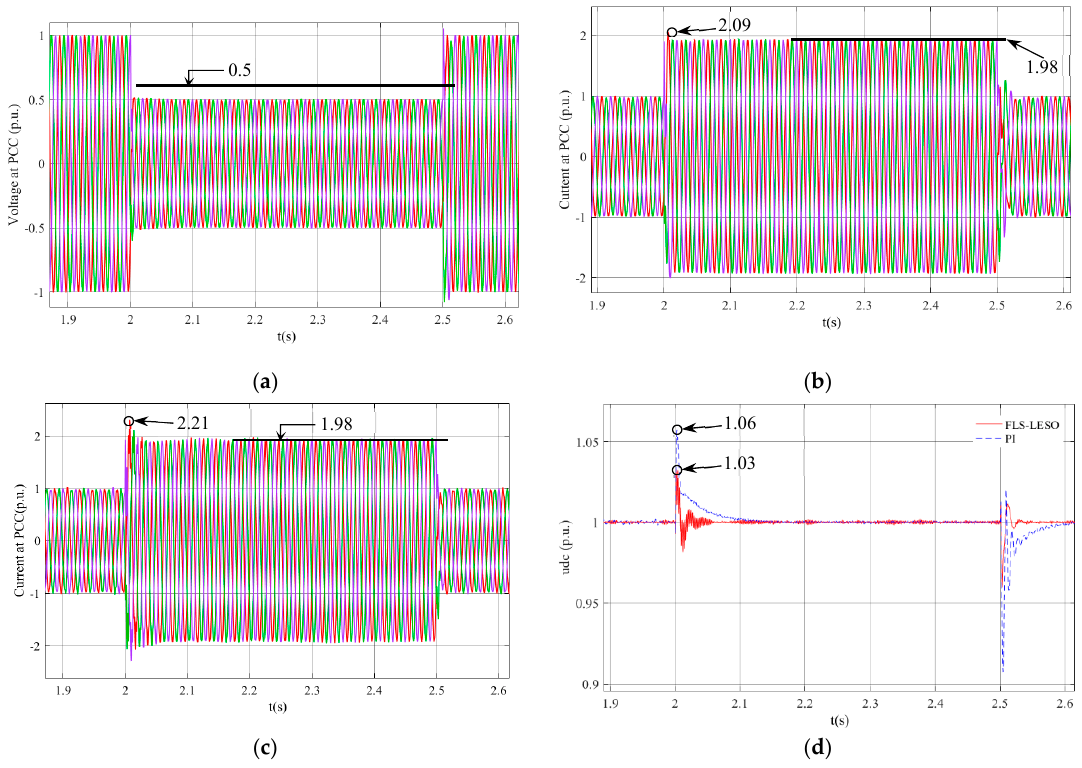
Figure 12. ( a – d ). Dynamic response of a 1.5 MW permanent magnet synchronous generator (PMSG) with the traditional PI controller and fuzzy logic system with linear extended state observer (FLS-LESO) during a 50% symmetrical fault; ( a ) Voltage at PCC; ( b ) Current at PCC with the PI controller; ( c ) Current at PCC with the FLS-LESO; ( d ) DC link voltage.